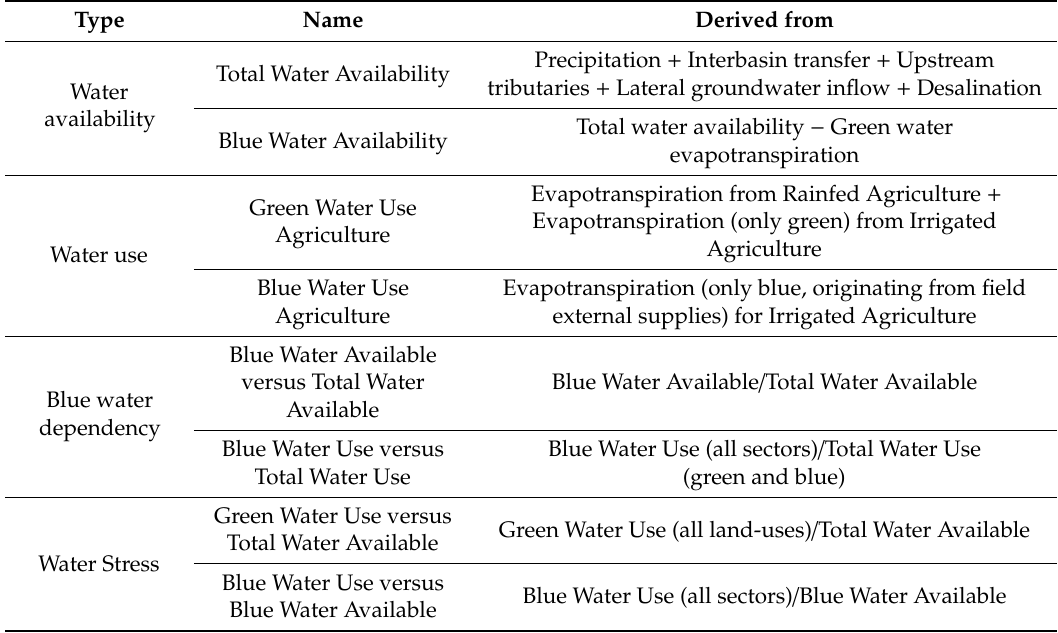
Table 4. Definition of the indicators